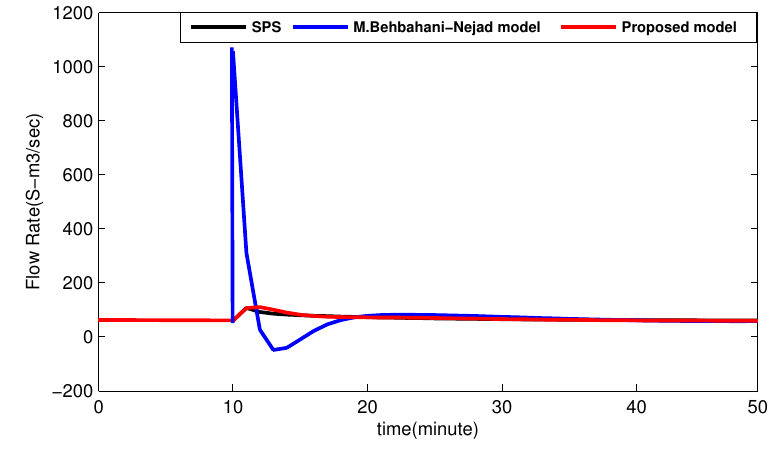
Figure 5. Inlet flow rate changes with time.